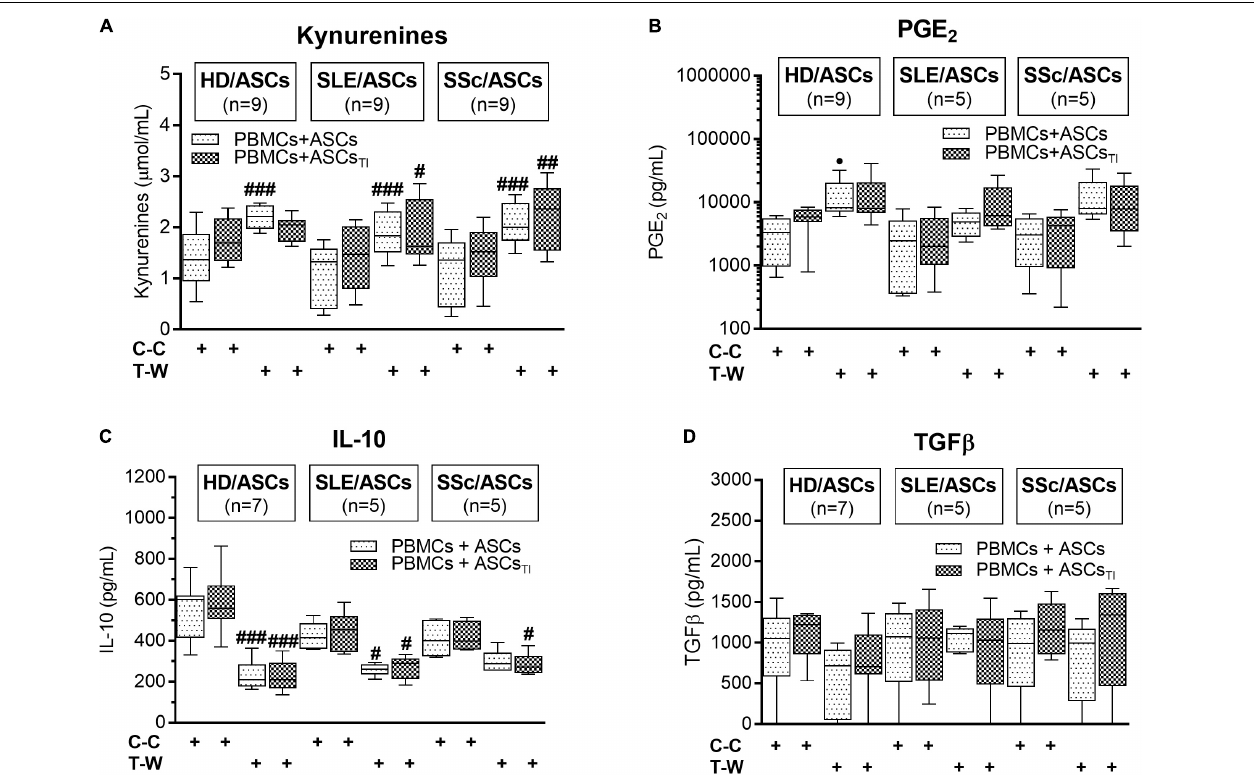
FIGURE 7 | Concentrations of soluble mediators in cell contact and transwell co-cultures of ASCs with PBMCs: (A) Kynurenines, (B) PGE2, (C) IL-10, (D) TGF β . The culture conditions and explanations as in Figure 3 . Data are the results of indicated number of experiments (n) in which 5 HD/ASCs, 5 SLE/ASCs, and 5 SSc/ASCs were co-cultured with PBMCs isolated from 9 healthy blood volunteers and are shown as the Tukey’s boxes. # P < 0.05, ## P < 0.01, and ### P < 0.001 for comparison of cell contact (C-C) vs. transwell (T-W)